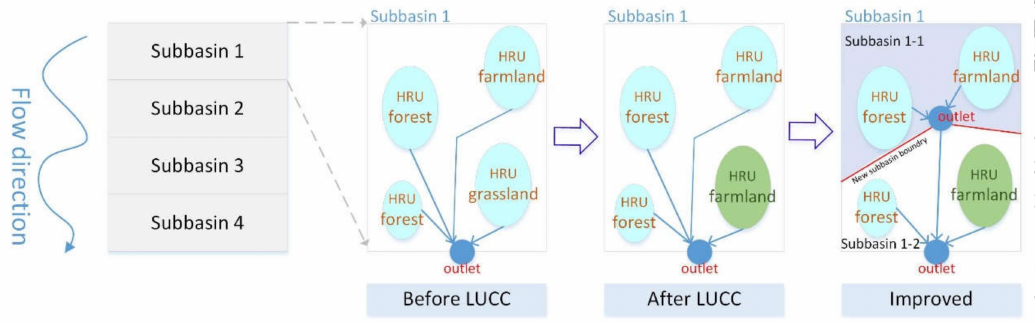
Figure 4. Sketch map of sub-basin segmentation considering the spatial relationship between land use/cover change (LUCC) and the existing river